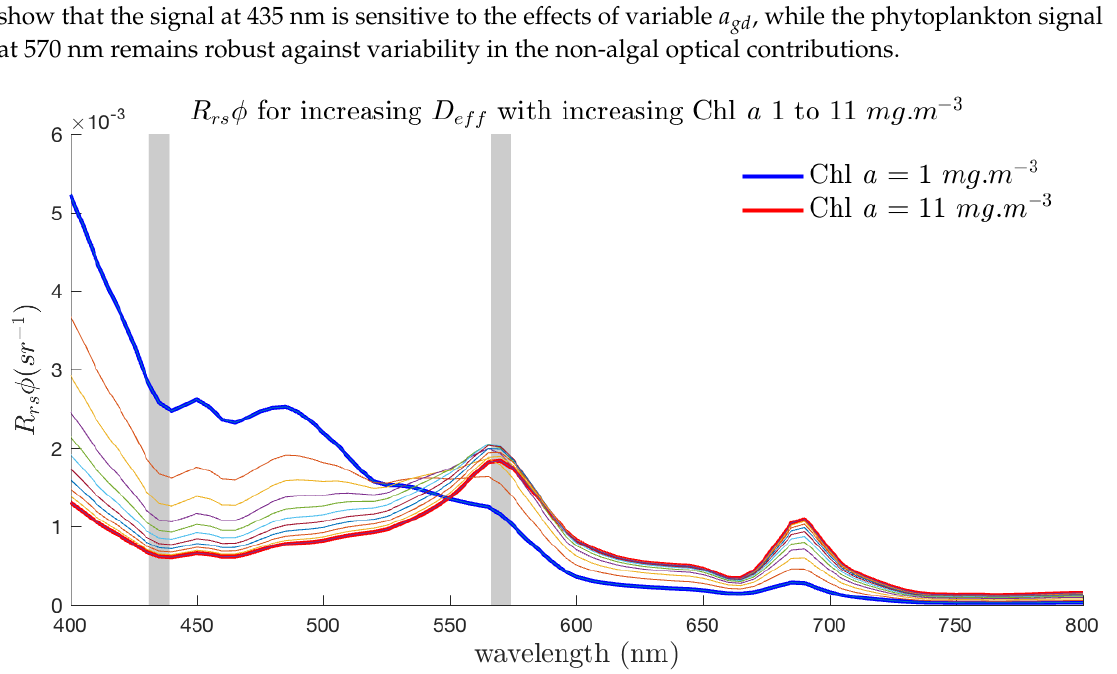
Figure 5. A simulated transition from 6 to 16 D ef f with biomass 1 to 11 mg/m 3 . Intermediate values of D ef f and Chl a are simply linearly interpolated. The lines highlight 435 nm and 570 nm, regions of maximum size signal, which are (at 435 nm) and are not (at 570 nm) sensitive to the effects of additional optical